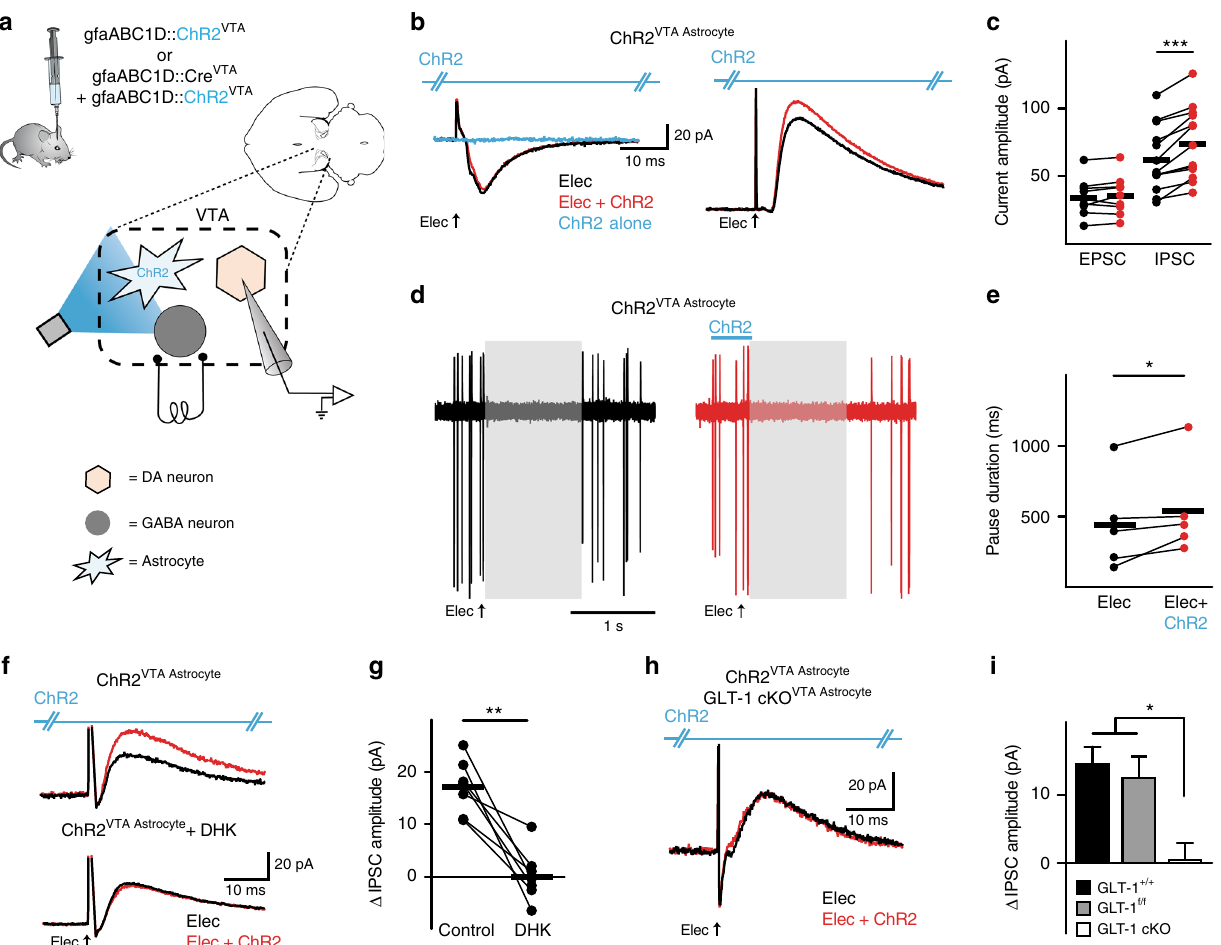
Fig. 3 Astrocytic GLT-1 increases inhibition of VTA dopamine neurons. a Schematic showing the microcircuitry of the VTA and manipulations performed. b Example voltage-clamp recordings (left V h = − 55 mV, right V h = + 10 mV). For dopamine neurons, the outward current (right), not the inward current (left), increases when ChR2 is photoactivated concurrently with electrical stimulation (Elec.) of neuronal afferents (red traces) in a GLT-1 + / + mouse. Photoactivation of ChR2 alone elicits no response (blue trace, and see Supplementary Fig. 8). c Summarized data from VTA dopamine neurons where ChR2 stimulation on VTA astrocytes increases peak IPSC amplitude (GLT-1 + / + , paired t -test t (12) = 5.894, P = 0.0001, n = 13 cells, 8 mice) without altering EPSCs (paired t -test t (9) = 1.129, P = 0.28, n = 10 cells, 8 mice). d Nine overlaid traces of a cell-attached recording and e summarized data from VTA dopamine neurons demonstrating an increase in pause duration (paired t -test t (4) = 2.815, P = 0.04, n = 5 cells, 2 mice) when ChR2 stimulation on VTA astrocytes is delivered concurrently with electrical stimulation of neuronal afferents (red traces; gray areas are the pause duration following electrical stimulation alone). f , g The increase in IPSC amplitude (red trace, top) is abolished by pharmacologically blocking GLT-1 with 300 µ M DHK (bottom traces). h When GLT-1 is conditionally knocked out from VTA astrocytes there is no change in IPSC caused by activating ChR2 on astrocytes. i Summarized data comparing the change in IPSC amplitude between GLT-1 + / + (GLT-1 + / + , gfaABC1D::ChR2 VTA ), GLT-1 f/f (GLT-1 f/f , gfaABC1D::ChR2 VTA ), GLT-1 f/f , and GLT-1 cKO VTA Astrocyte mice (One-way ANOVA, F ( 2,27) = 7.732, P = 0.0022; post-hoc Tukey ’ s test GLT-1 + / + vs GLT-1 f/f P > 0.05, GLT-1 + /